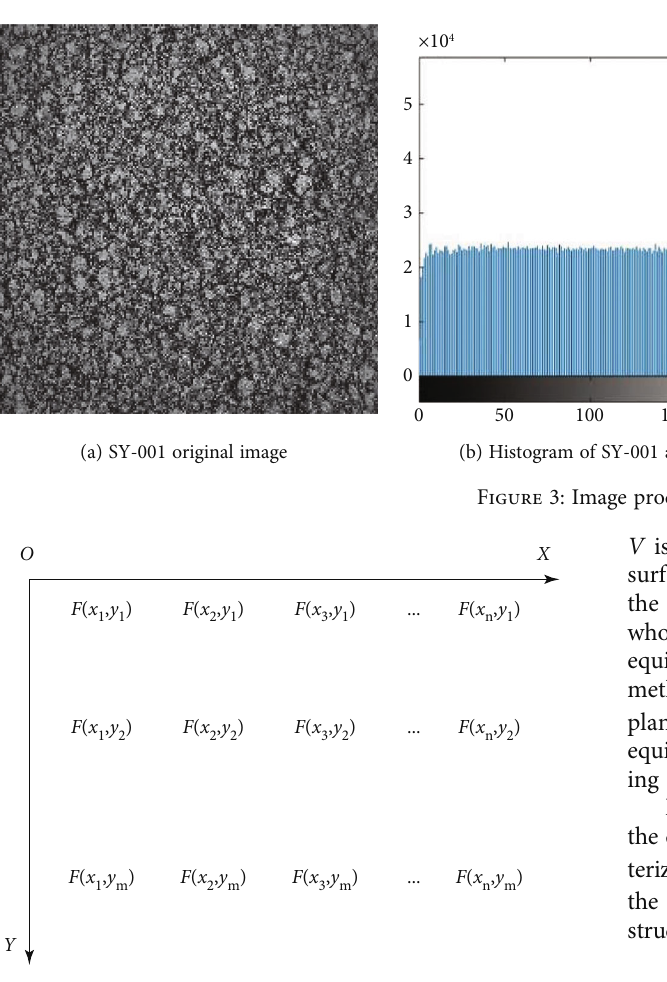
Figure 4: 2D numerical matrix of the grayscale